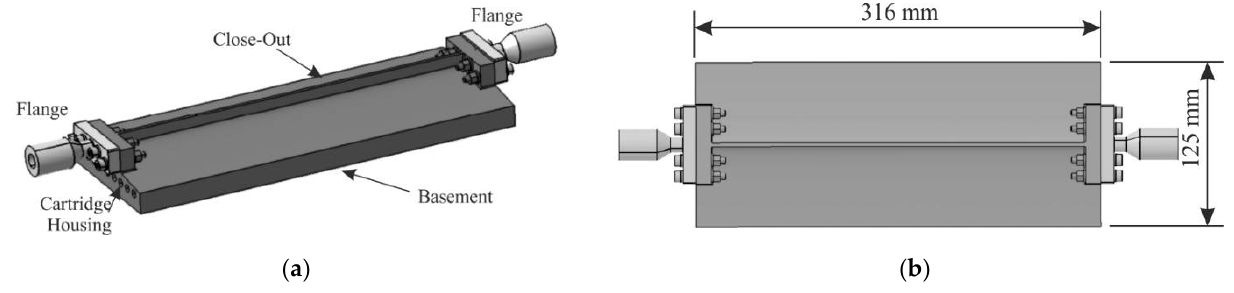
Figure 8. MTP breadboard: ( a ) under test; ( b ) geometrical information.